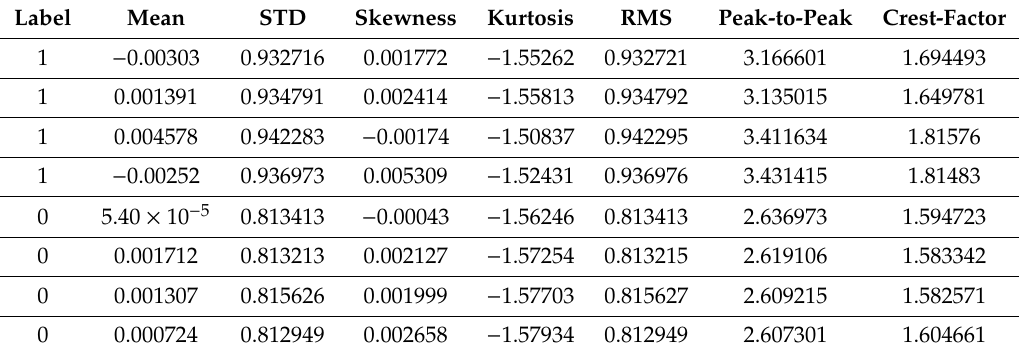
Table 3. Statistical features